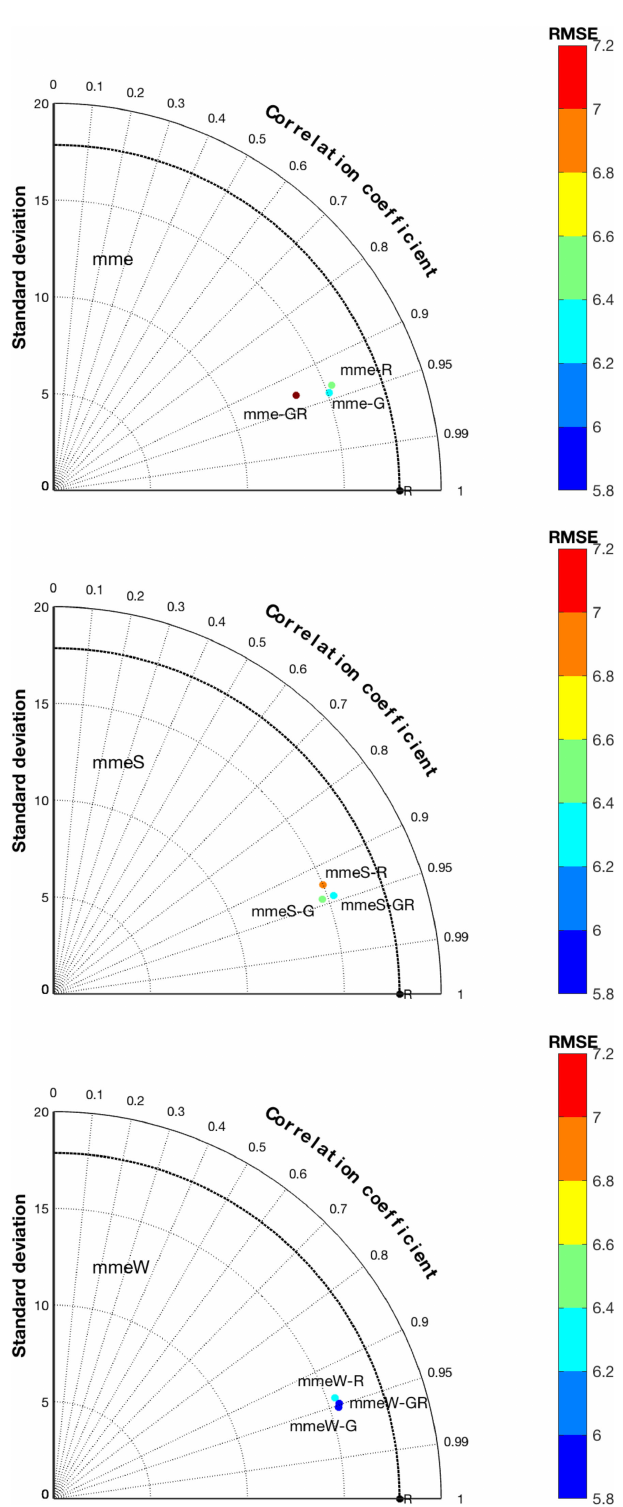
Figure 8. Comparison of the performance of three ensemble treat- ments (mme, mmeS and mmeW) for three groupings of models (re- gional – R; global – G; and mixed global and regional –